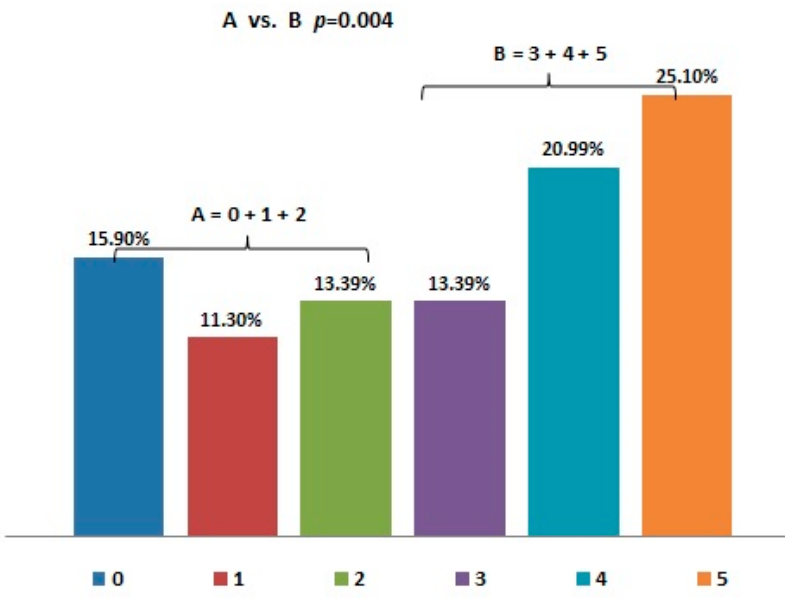
Figure 1. Assessment of the impact of air pollution on their health by patients with lung diseases (from 0—no influence of pollution to 5—very strong influence). The study group was divided into two subgroups. Group A consisted of patients declaring no impact, very weak, and weak impact of air pollution on their health, while group B consisted of patients who declared moderate, high, and very high impact.